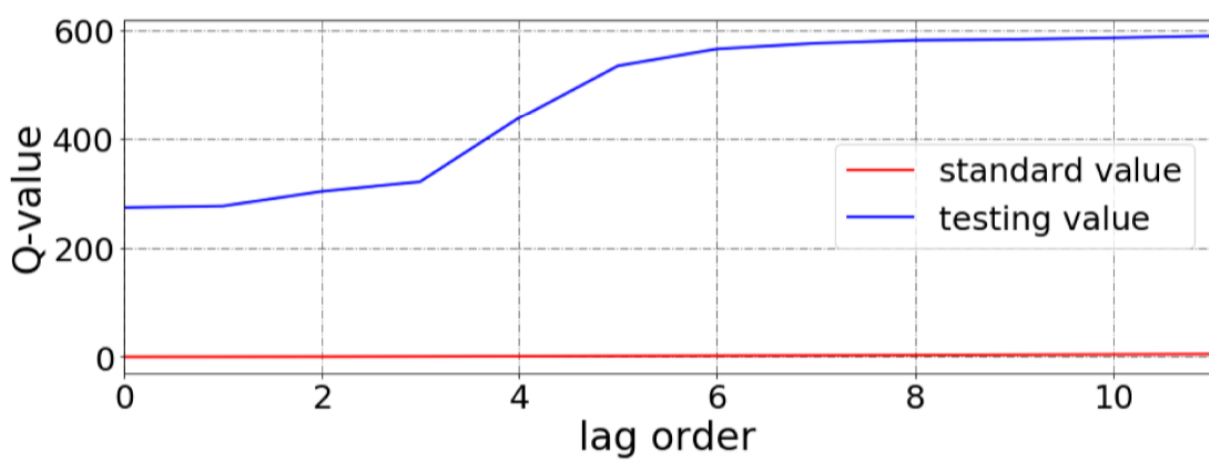
Figure 9. Box_Ljung value of each lag order.